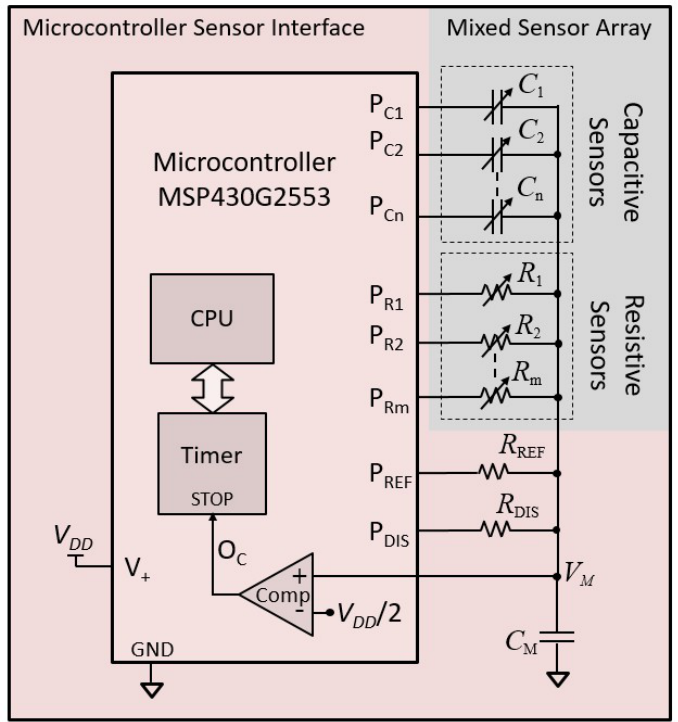
Figure 2. Microcontroller sensor interface for the capacitive and resistive mixed sensor array.